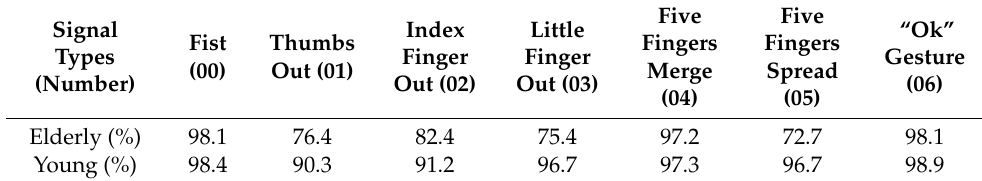
Table 2. Gesture recognition rate.